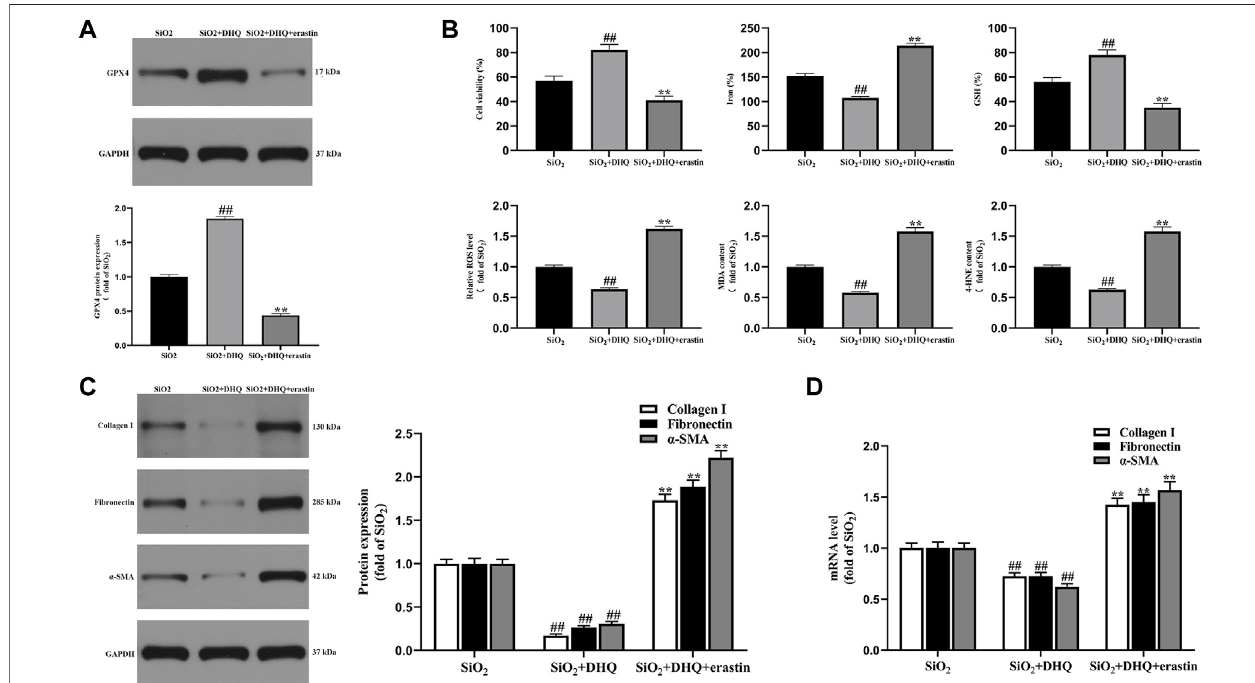
FIGURE4| Activation offerroptosis impaired DHQ-induced anti- fi brosis effects in vitro (A) The protein expressionsofGPX4 inactivated HBE cells weremeasured by western blotting. (B) The analysis of cell viability and major biomarkers of ferroptosis (iron, GSH, ROS, MDA and 4-HNE) in activated HBE cells. (C) The protein expressionsof α -SMA,collagenIand fi bronectininMRC-5cellsstimulatedwithconditionedmediumofHBEcellsweremeasuredbywesternblotting. (D) Theanalysisof realtime-PCRof α -SMA,collagenIand fi bronectininMRC-5 cells.Dataareshownasmean±SD( n =3).# p < 0.05,## p < 0.01vs. theSiO 2 group;* p < 0.05,** p < 0.01 vs. the SiO 2 +DHQ